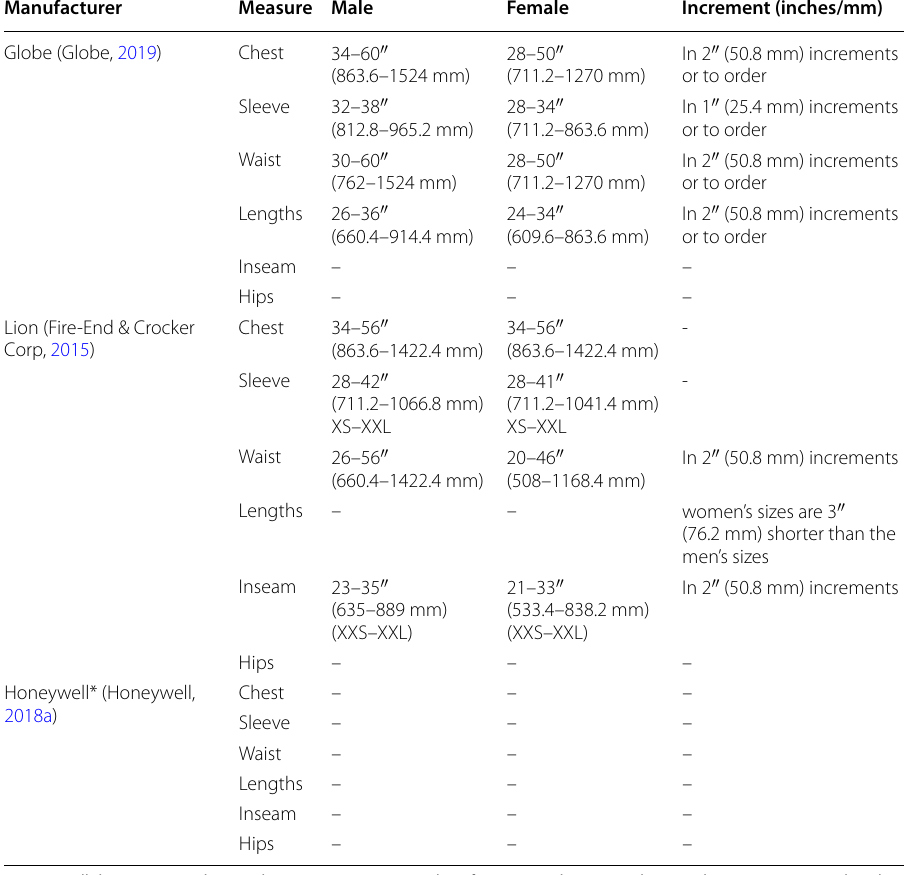
*Honeywell does not provide an online size measurement chart for coats and pants, as their products are custom tailored